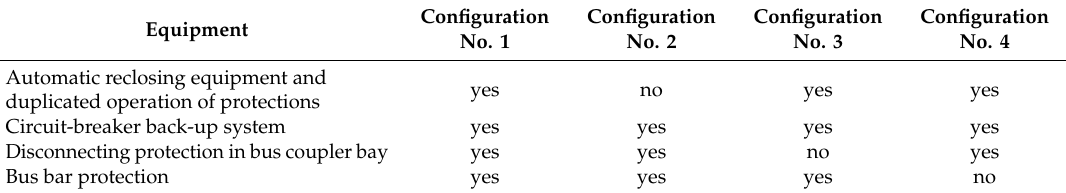
Table1. ConfigurationsofPowerSystemProtectionAutomaticsPSPAequipmentinconsideredsubstations.